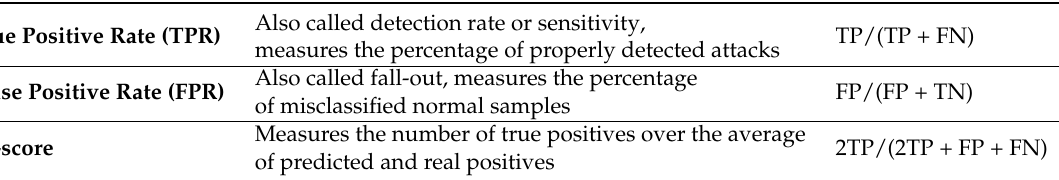
Table 3. Metrics summary.